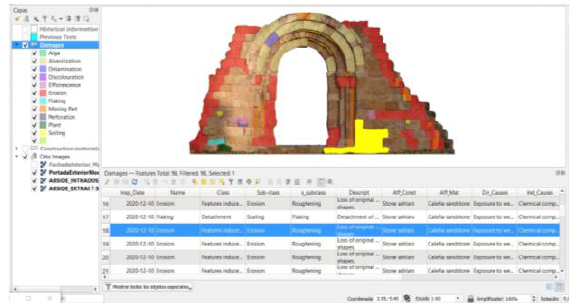
Figure 9. Damage mapping captured by using the Qfield application and managed in the QGIS desktop software.